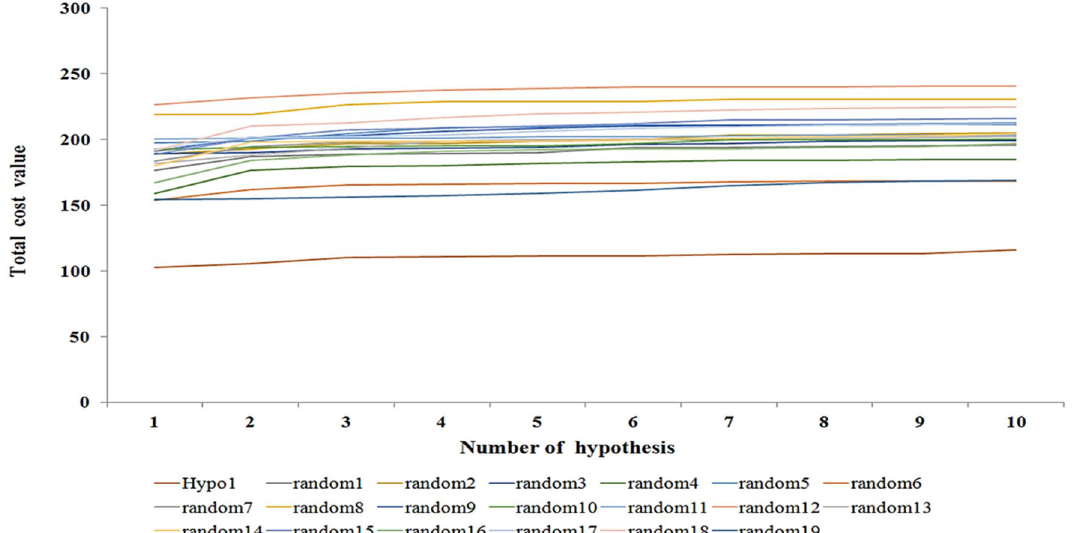
Figure 4. A graphical representation of the total cost values of Hypo 1 and each of ten hypotheses generated from 19 random spreadsheets during Fischer’s randomization run. A confidence level of 95% was used. The figure is drawn using Microsoft Excel 2013